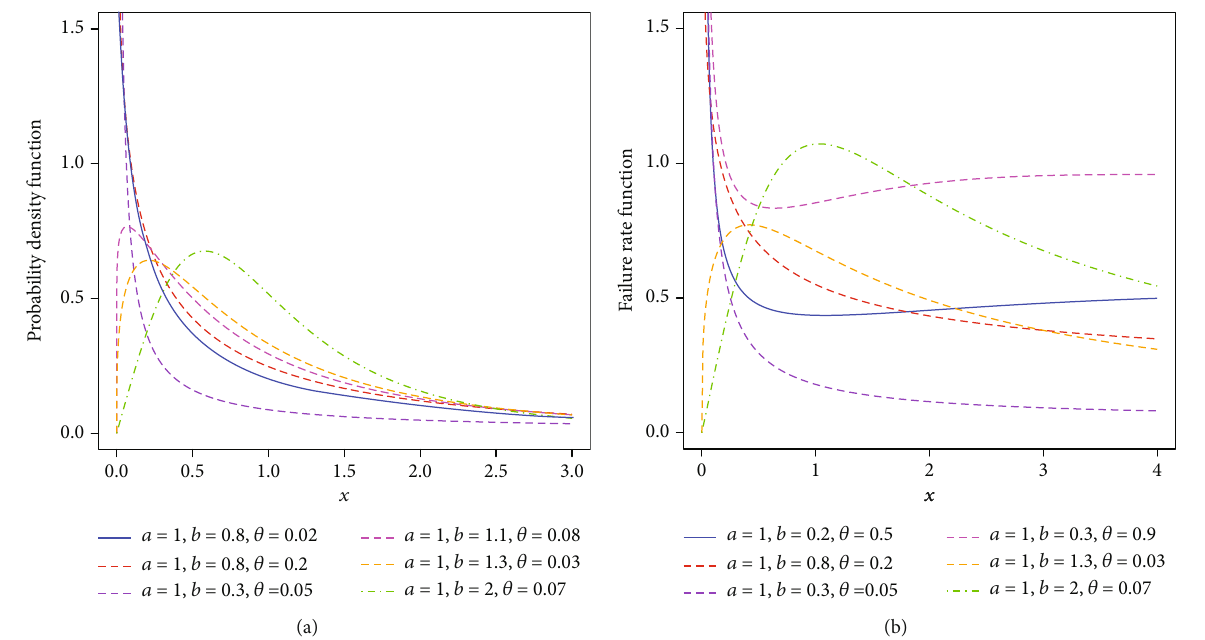
Figure 1: The PDF (a) and the FR function (b) of the MLL for some parameter values.